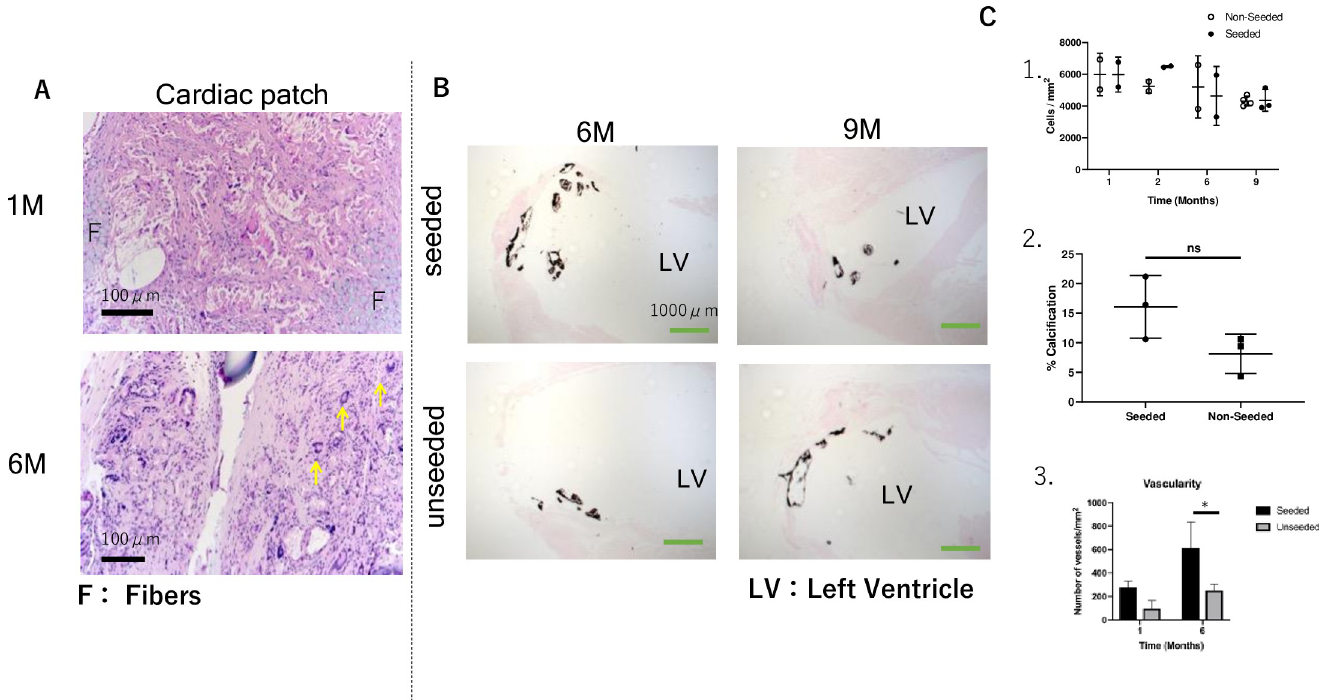
Fig 6. (A): Cells can infiltrate and attach to the scaffold four weeks after implantation. Hematoxylin and eosin staining revealed multinuclear giant cells (yellow arrows). (B): Von Kossa staining shows phosphate commonly associated with calcification in the LV at 24 and 36 weeks after implantation. (C):1. Number of cells in bioabsorbable patch at each time point. 2. Evaluation of calcification at 6 months after transplantation (n = 3). 3. Evaluation of the number of CD31 positive vessels 1 month and 6 months after implantation (n = 3/time point).